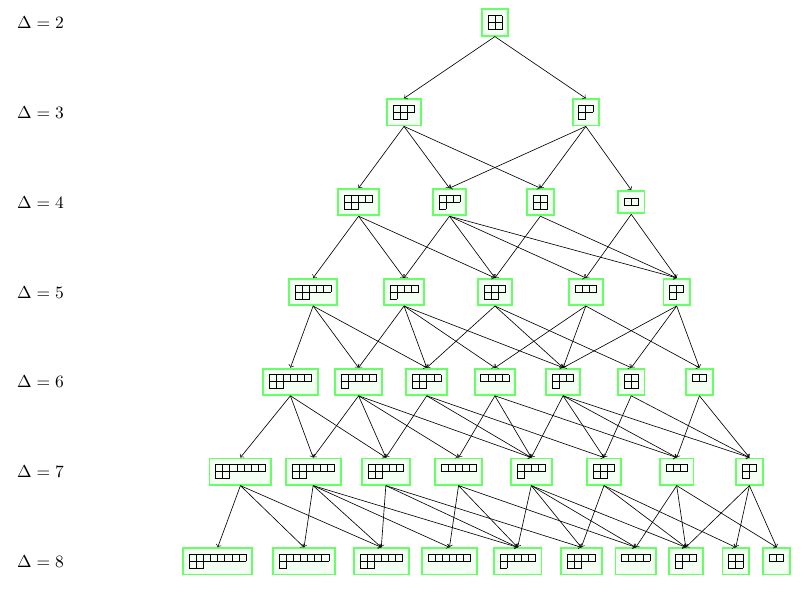
Figure 6. Off-shell